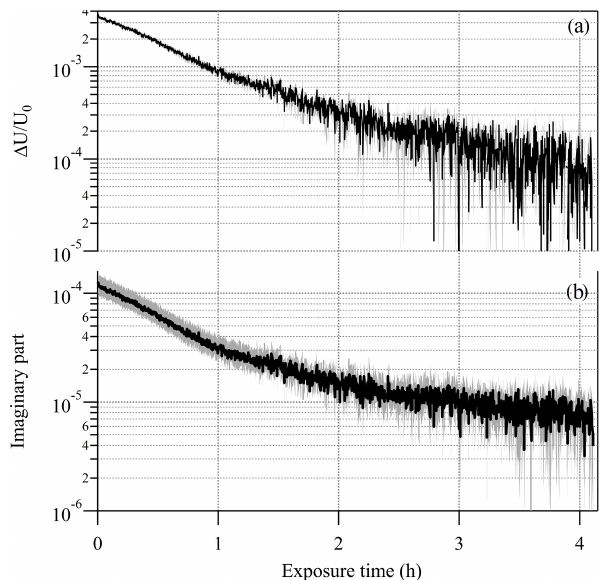
Figure 6. (a) Decay of the EDB photophoretic response ( (cid:49)U/U 0 ) during illumination of a slightly absorbing particle (PEG400 with 0.23% wt of carminic acid; CA). The decay is due to the slow pho- tolysis of the CA. (b) The retrieved imaginary part of the complex refractive index. Gray shaded area in both plots represents the un- certainty in the measured and retrieved